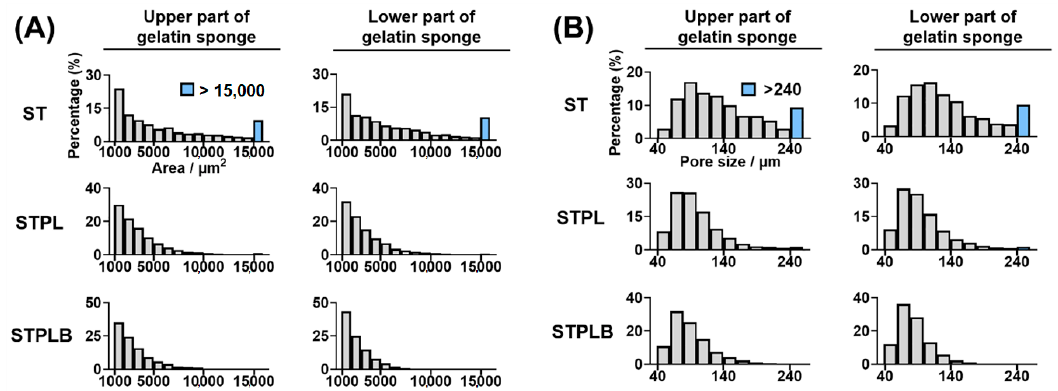
Figure 3. Distribution of pore area ( A ) and size ( B ) in horizontally sectioned gelatin sponges prepared using different molds. The data were obtained through quantitative image analysis using ImageJ software. ST: silicon tube showing high permeability; STPL: ST covered with PVDC at the lateral side; STPLB: ST covered with PVDC at the lateral and bottom sides. Representative data from four different images.